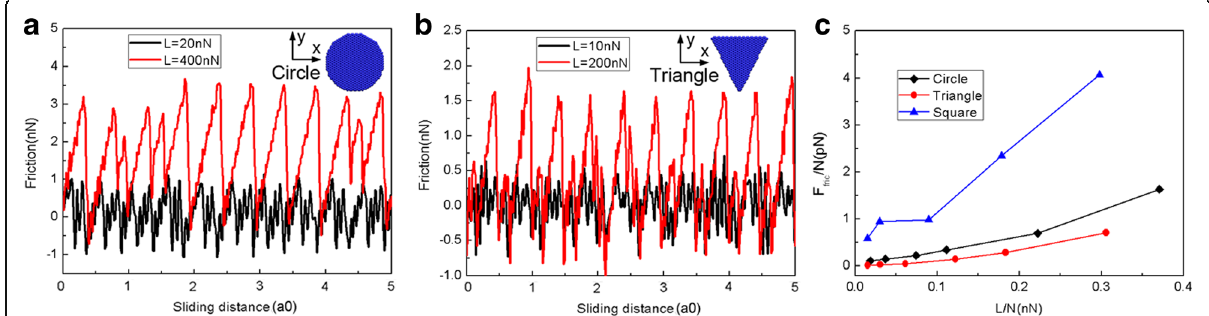
Fig. 4 The variation of friction force and average friction force for different flake shapes. The typical friction force as a function of sliding distance for the round ( N = 1080 atoms) flake ( a ) and triangular ( N = 654 atoms) flake ( b ). c The average friction force per atom ( F fric /N) as a function of load per atom (L/N). Here, a0 (= 9.99 Å) is the lattice spacing of Au(111) along the sliding direction